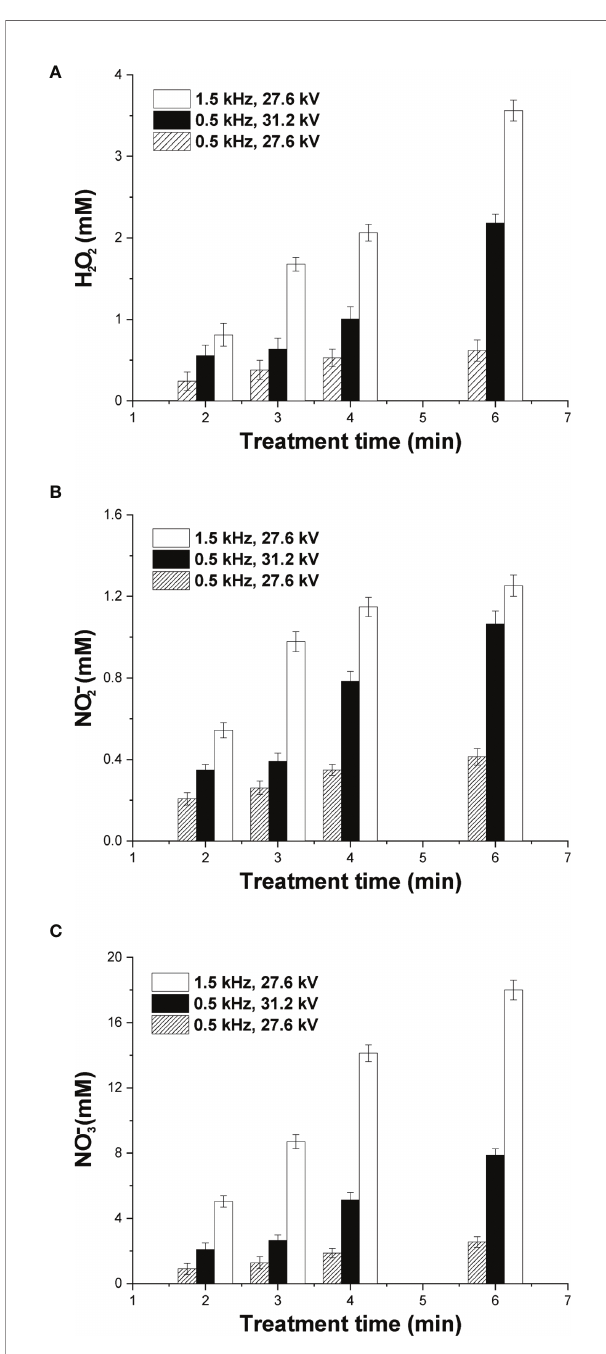
FIGURE 3 | Quanti fi cation of major DBD-CAP-originated ROS/RNS. Concentration of (A) H 2 O 2 ; (B) NO − 2 ; (C) NO − 3 in cell-free culture media (DMEM with 10% FBS) exposed to various plasma treatment times at different pulse voltages and frequencies. The values represent the mean ± SD of 3 (at least) independent